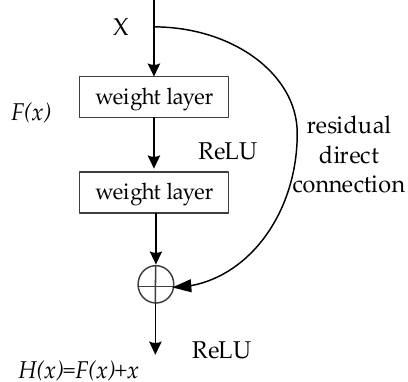
Figure 4. Basic residual unit structure diagram [58].